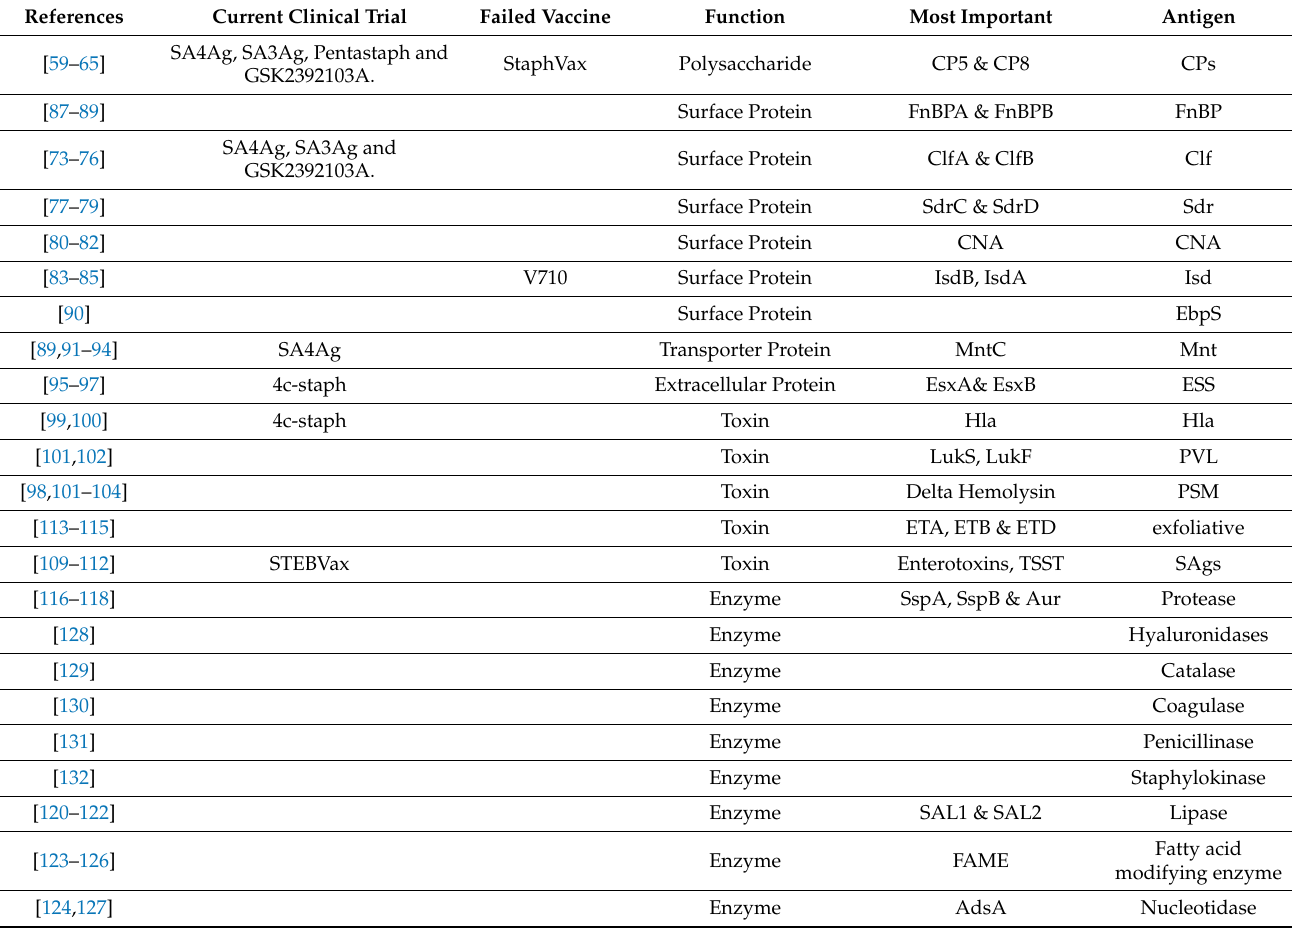
Table 2. The most important virulence factors of S. aureus